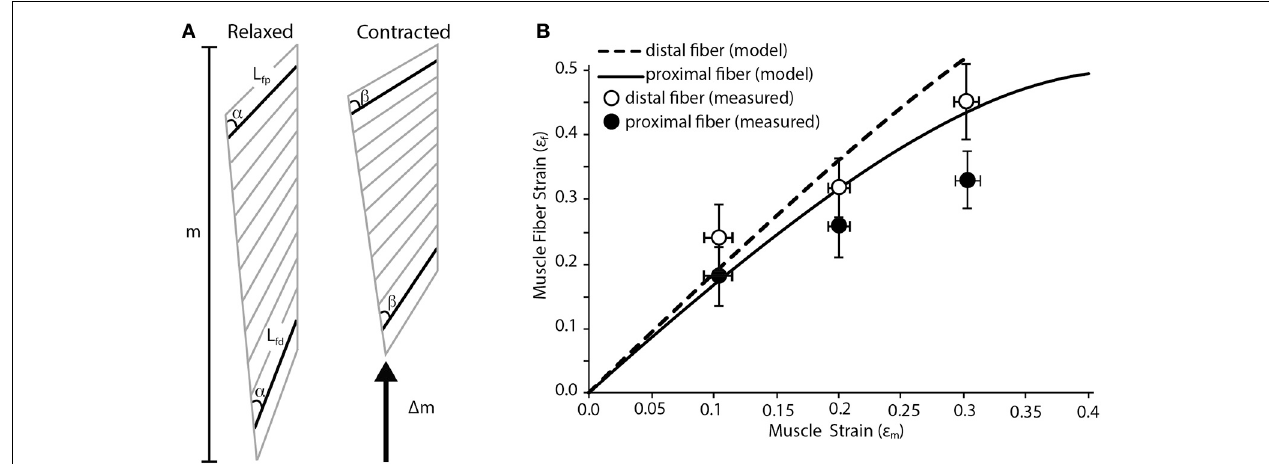
FIGURE 1 | Fiber strain heterogeneity in a pennate muscle. (A) Schematic of pennate muscle fiber arrangement during relaxed and contracted conditions. The schematic is based on the anatomy of turkey gastrocnemius muscle. m denotes the relaxed length of the muscle. During contraction there is a change in muscle length ( (cid:2) m) along the line of action of the muscle. L fp is the length of the proximal fiber, which has a pennation angle of about 30 ◦ . L fd is the length of the distal fiber, which has a pennation angle of about 20 ◦ . Although the initial thickness of the muscle varies along the proximal to distal axis, the thickness does not change dynamically during the contraction. There